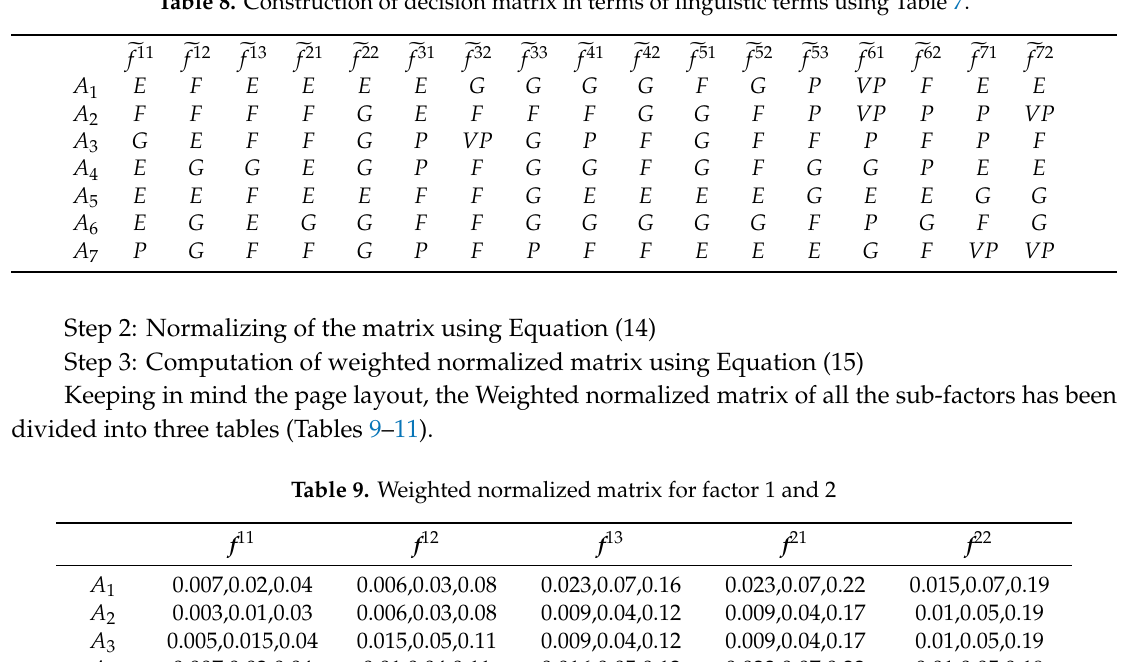
Table 8. Construction of decision matrix in terms of linguistic terms using Table 7.